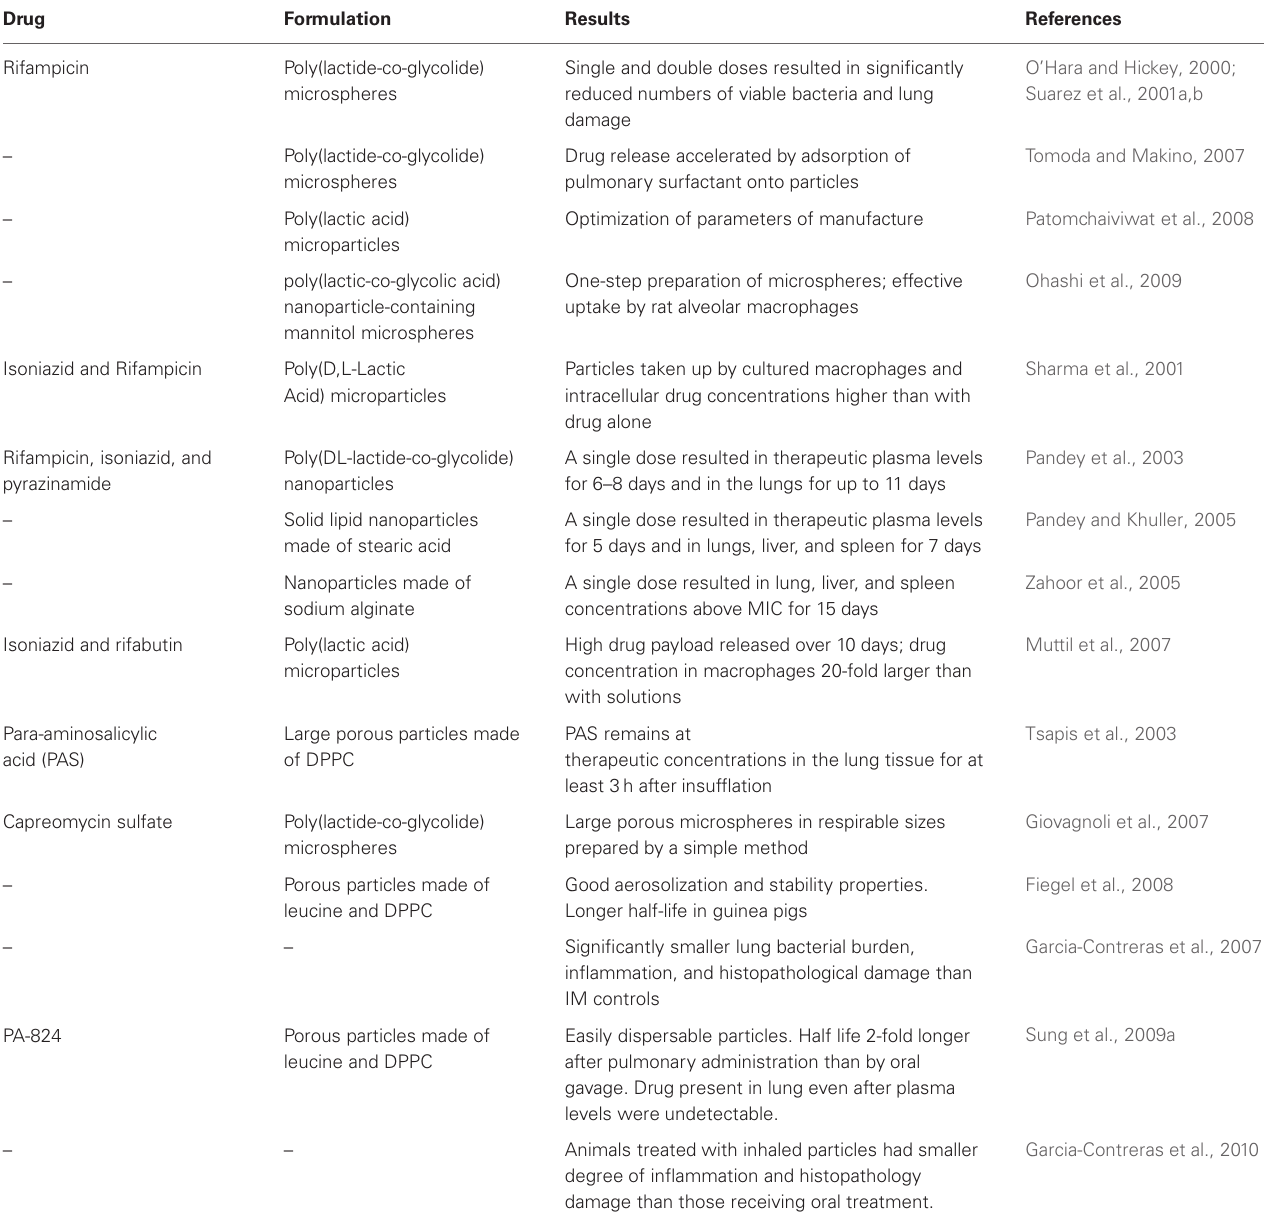
Table 1 | Novel inhalable formulations for anti-tubercular